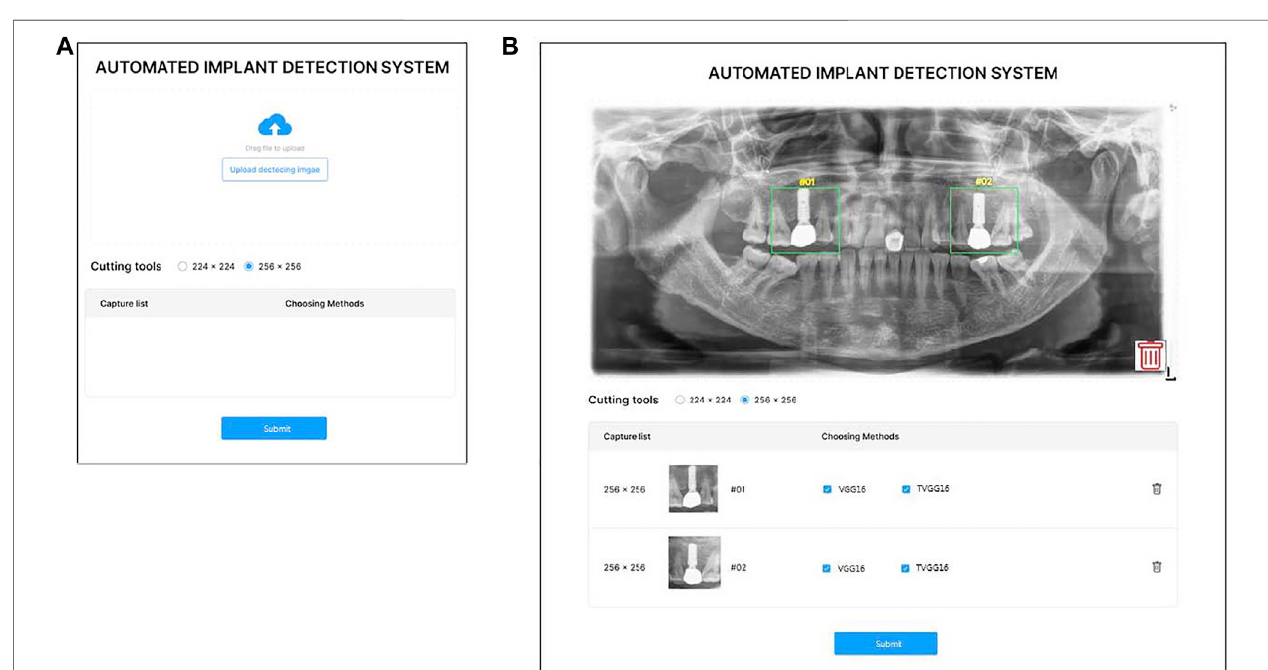
FIGURE 2 | GUI of the proposed system (A) is the entry GUI (B) is the model selection and RoI speci fi cation GUI.